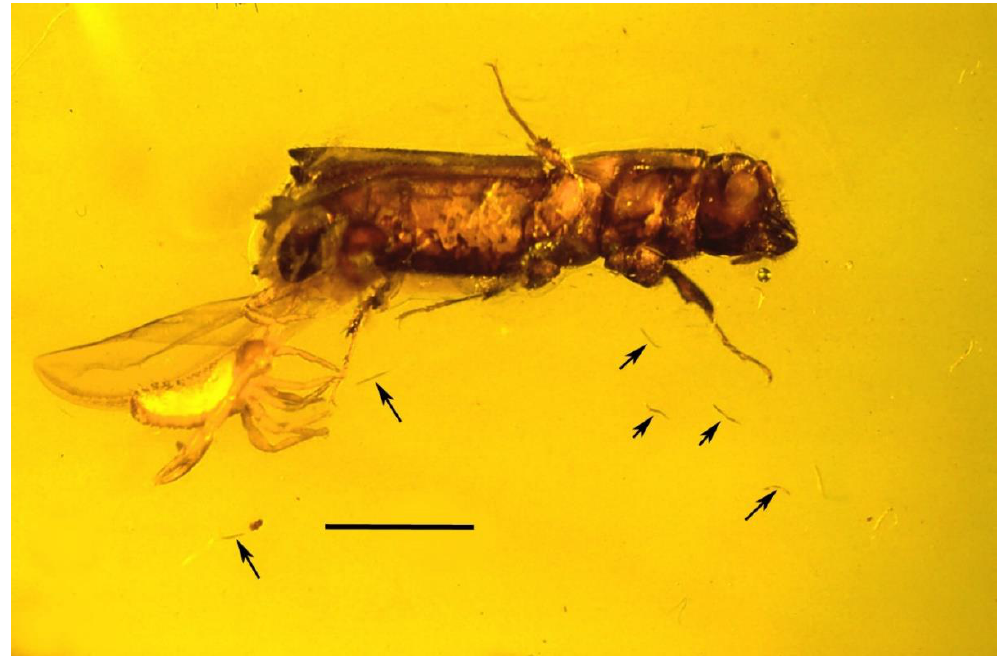
Figure 8. Adult pseudoscorpion ( Parawithius sp.: Pseudoscorpiones: Withiidae) clasping a platypodine beetle ( Cenocephalus rhinoceroides : Coleoptera: Curculionidae: Platypodinae) with one chela in Dominican amber. Arrows show phoretic nematodes that became detached from the beetle. Scale bar = 990 µm.